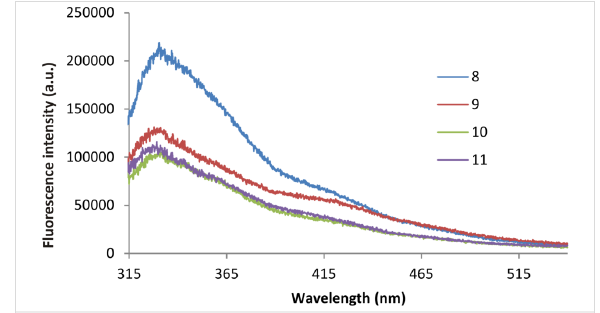
Figure 4: Fluorescence spectra of compounds 8 – 11 in methanol (1 × 10 − 5 М